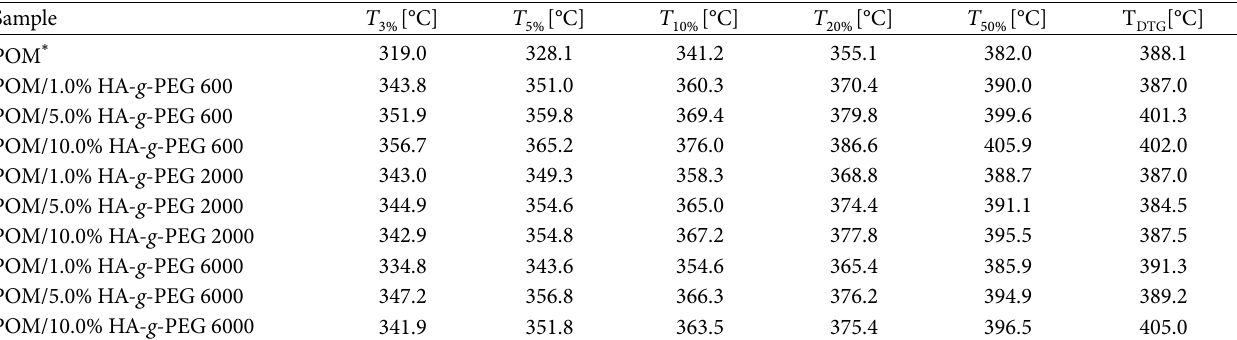
Table 3: Thermal stability of POM/HA- g -PEG composites.